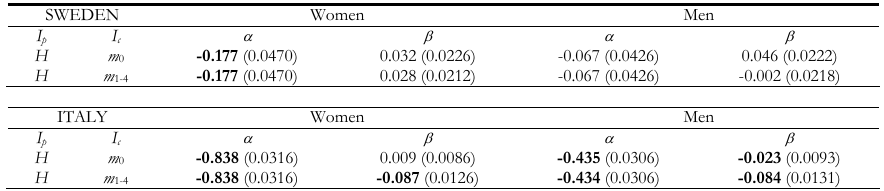
Estimated parameters (cid:68) and (cid:69) (cid:15) with standard errors (in parenthesis). We depicted in bold parameters statistically significant at 95%. Sweden (top) and Italy (bottom), both sexes